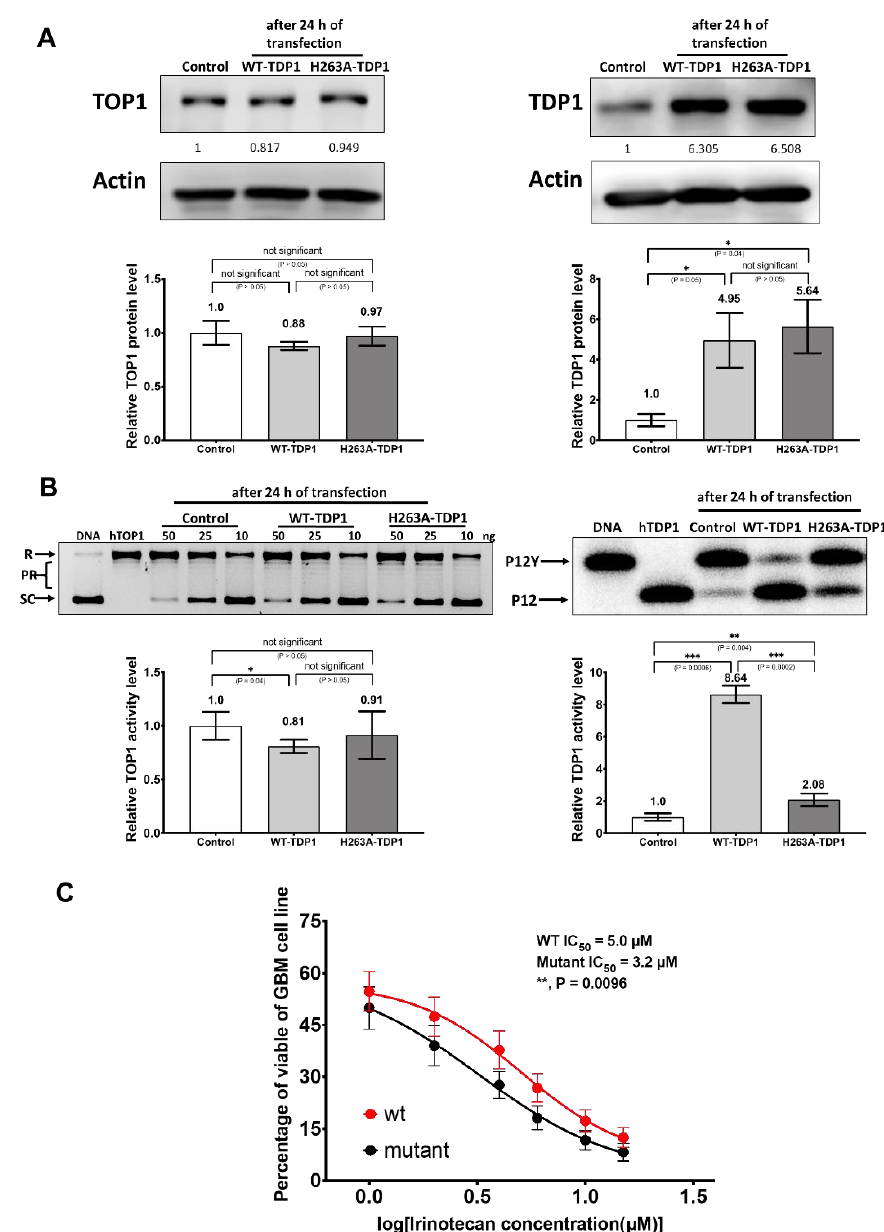
Figure 6. Transfection of TDP1 into the H4 cell line to elevate the TDP1/TOP1 activity ratio and increase the irinotecan IC 50 . ( A ) TDP1 and TOP1 protein levels after transfection of H4 with wild type (WT-TDP1) or mutant (H263A-TDP1) clones. Cells were collected 24 h after transfection and 10 µ g of WCEs were analyzed by western blots. Whole blots with molecular weight markers are shown in Figure S6. The signal from actin was used to control the loading of WCE proteins. Normalized intensity ratios are given for each band, with the intensity ratio of mock-treated control set as 1. The bar graphs show the average and standard deviation of measurements as error bars from all technical replicates (n = 3 or more); ( B ) TDP1 and TOP1 activity levels in H4 WCE from the transfection of WT-TDP1. Cells were collected 24 h post-transfection and 4 µ g of WCE was used in the gel-based assay for TDP1 activity; ( C ) Irinotecan IC 50 for H4 cells transfected with the WT-TDP1 clone versus H263A mutant TDP1 clone (n =